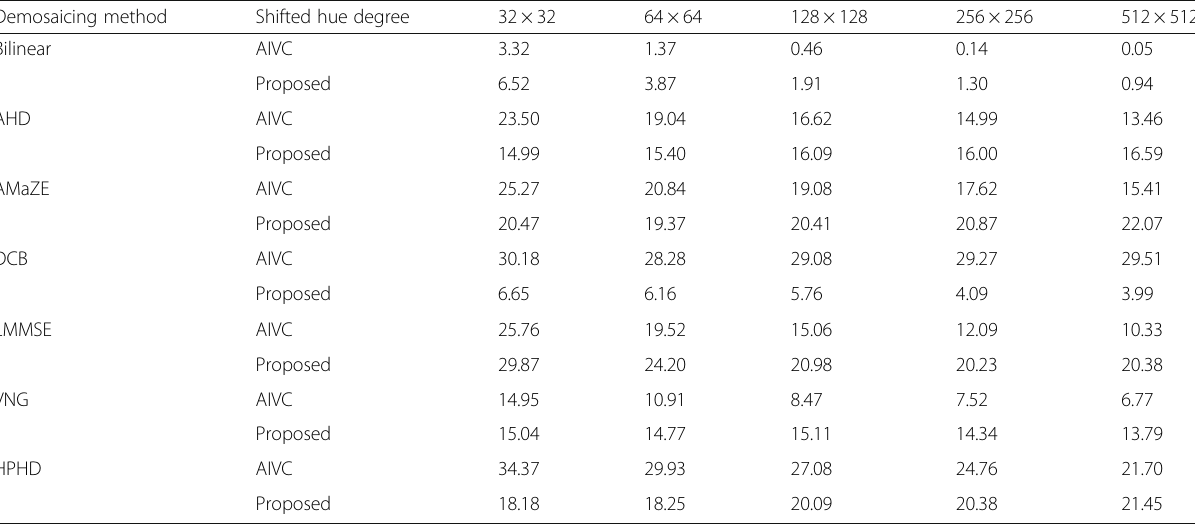
Table 7 Mean error value comparisons between our method and the AIVC algorithm after white balancing and gamma correction for various block sizes Demosaicing method